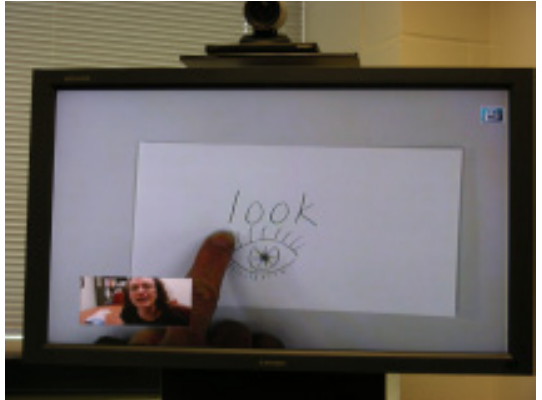
Figure 3. Large image from document camera with picture-in-picture image of